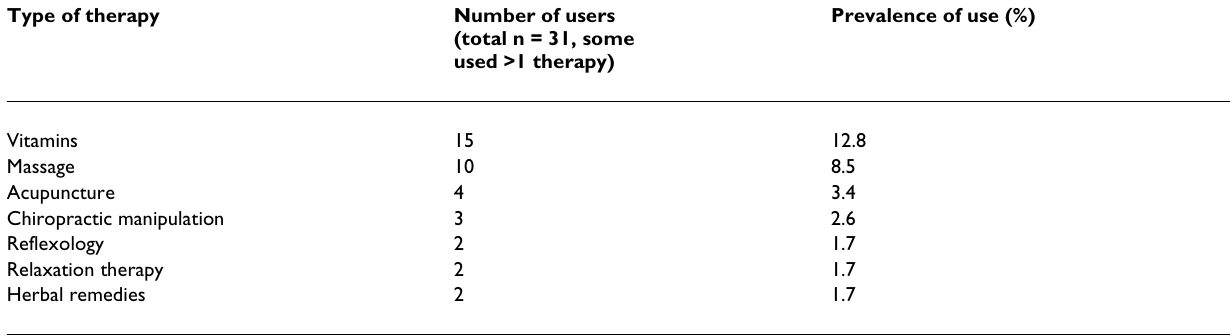
Table 1: Types of therapy used Type of therapy